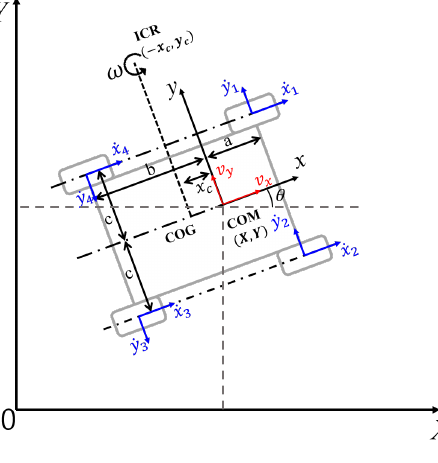
Figure 1. Four wheeled skid steered vehicle kinematics